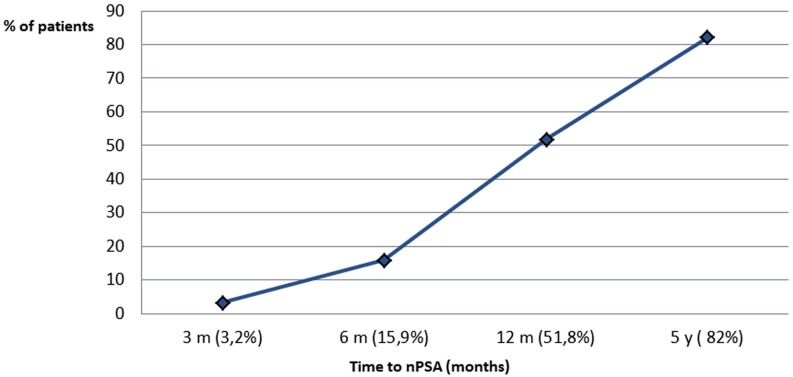
% patients reaching nPSA at specific intervals. 50% of the patients reached the nadir 1 year after brachytherapy, 82% of the patients reached the PSA nadir 5 years postoperatively.